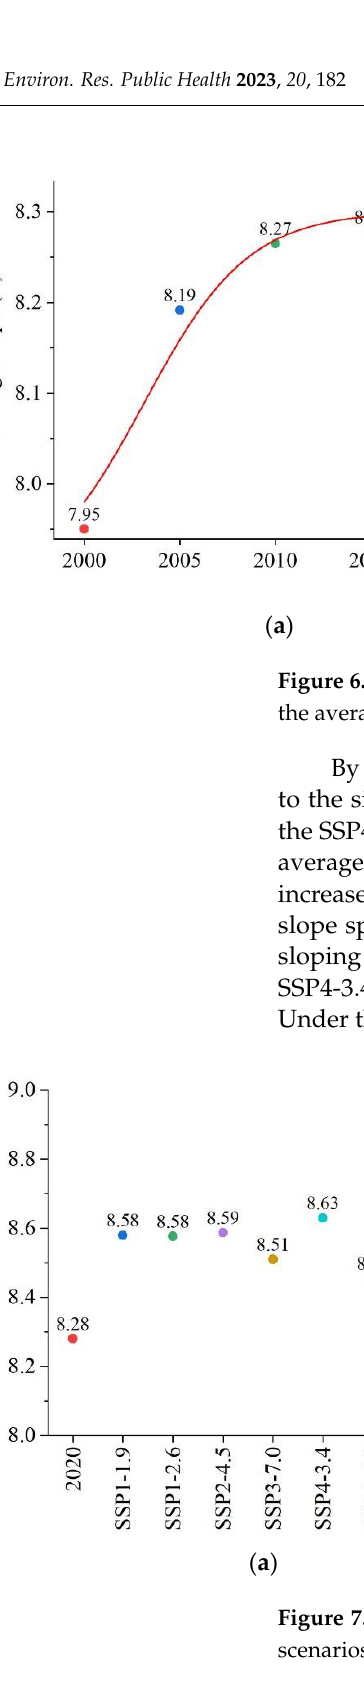
( b ) Figure 5. Predicted change trends in cropland and sloping cropland under different scenarios. ( a ) Predicted cropland areas in 2035. ( b ) Predicted sloping cropland areas in 2035. 4.4. Predictions of Cropland Slope Spectrum and ACCI